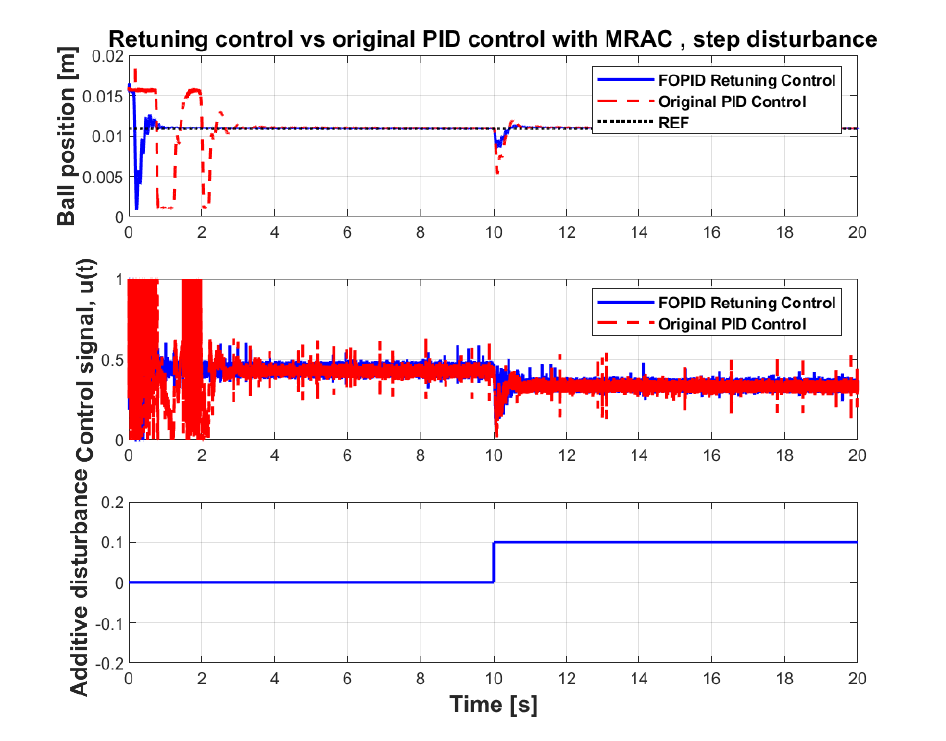
Figure 15. Step disturbance responses of the MRAC system with the original PID control